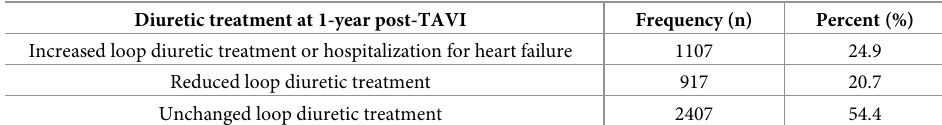
Table 2. Changes in loop diuretic treatment at 1-year post-TAVI. Diuretic treatment at 1-year post-TAVI Increased loop diuretic treatment or hospitalization for heart failure Unchanged loop diuretic